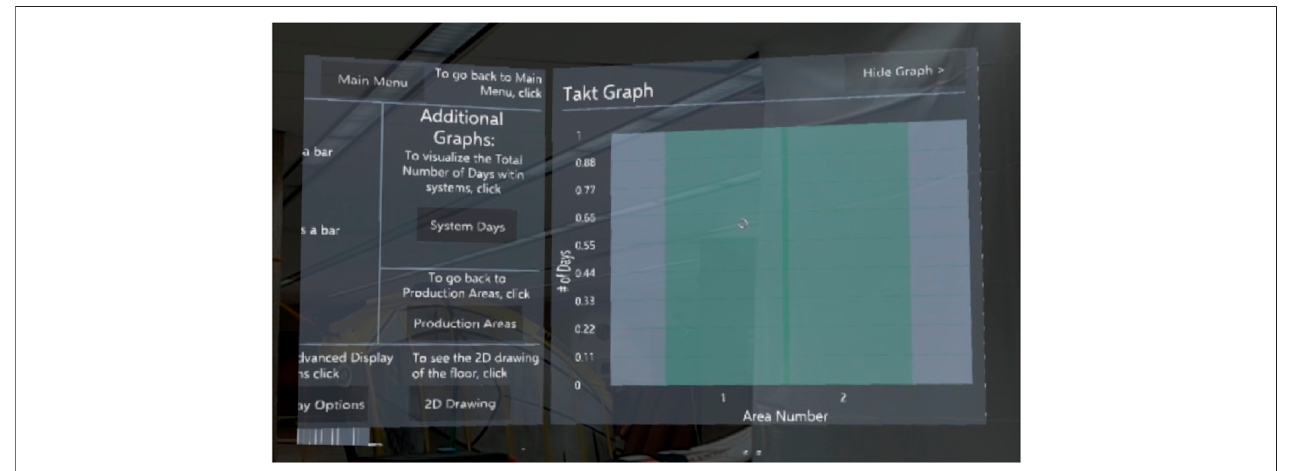
FIGURE 8 | Automated bar chart of number of days within the different production areas of the selected activity.